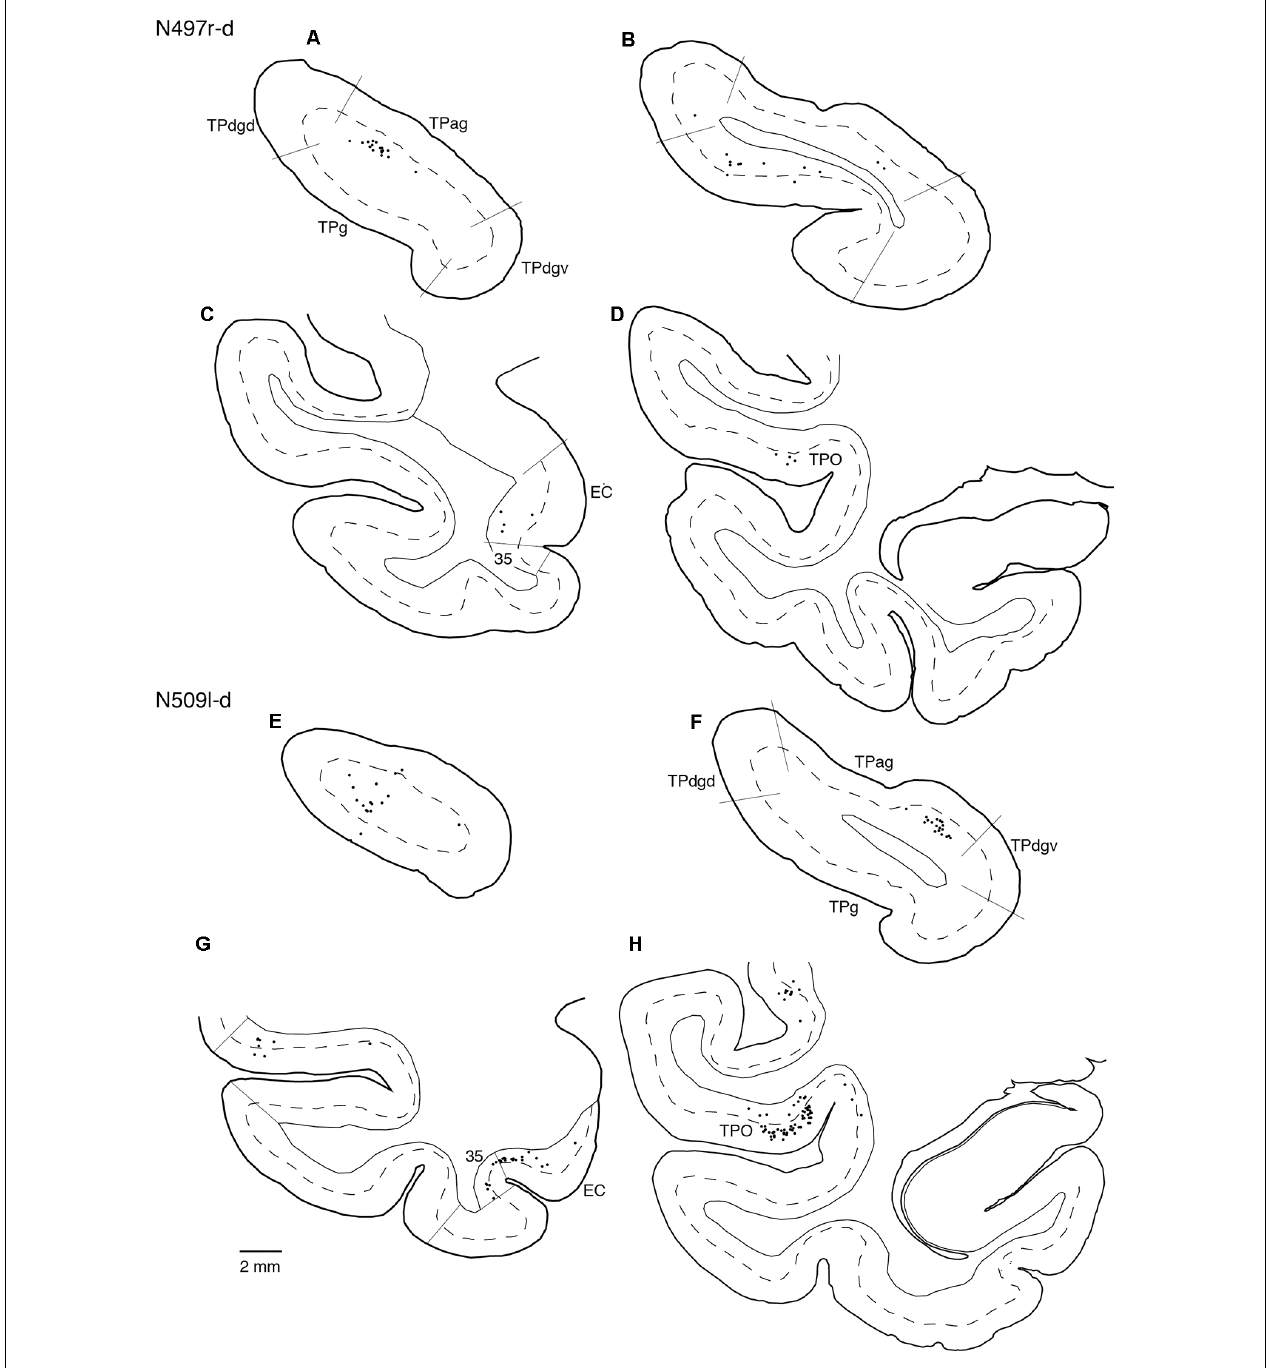
FIGURE 9 | Distribution of the labeled neurons in the TP (A,B,E,F) and other temporal cortical areas (C,D,G,H) after injections into the dACC (cases N497r-d and N509l-d). The conventions are the same as shown in Figures 4 , 5 .